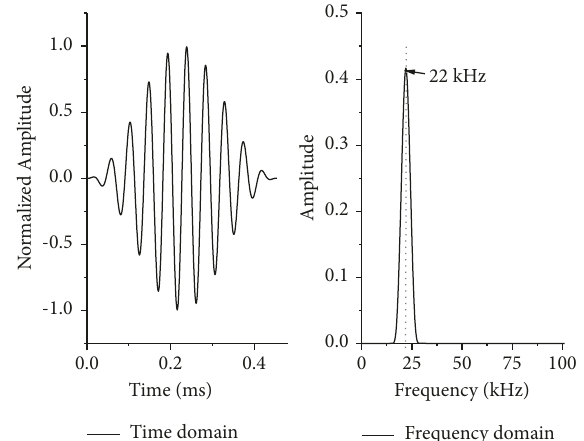
Figure 7: Excitation signal input for the numerical simulation [26].